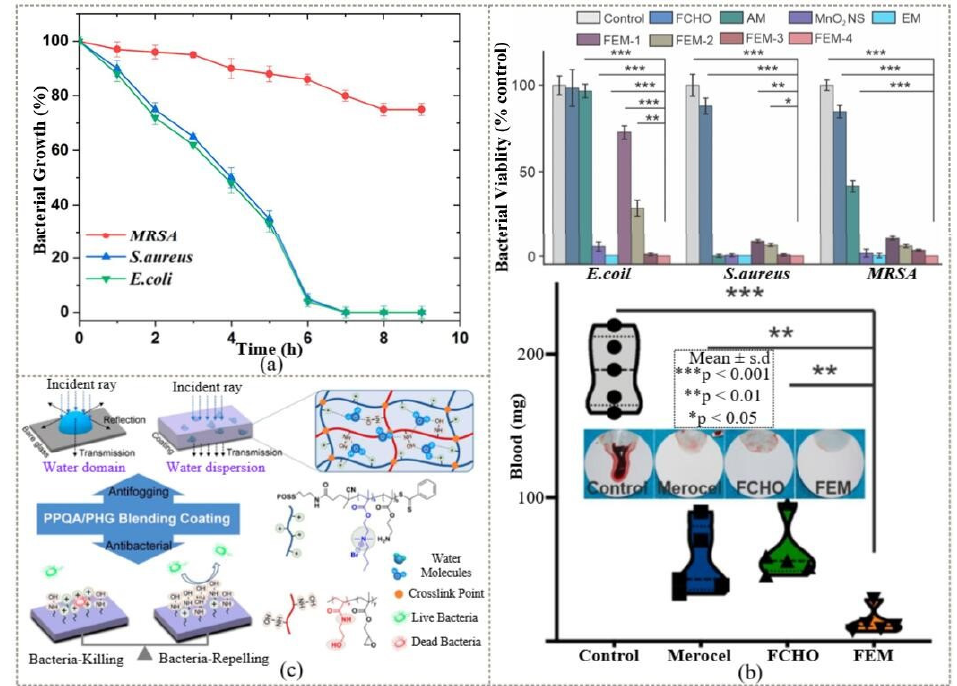
Figure 12. Effects of antibacterial coatings as in vitro medical aid materials: ( a ) time–killing curves of MRSA, Staphylococcus aureus , and Escherichia coli at compound concentrations of 120, 80, and 60 µg/mL, respectively [183]; ( b ) antibacterial performance and hemostatic ability of FEM hydrogel [189]; ( c ) description of antifogging and antibacterial properties of PPQA/PHG blended coatings [192].